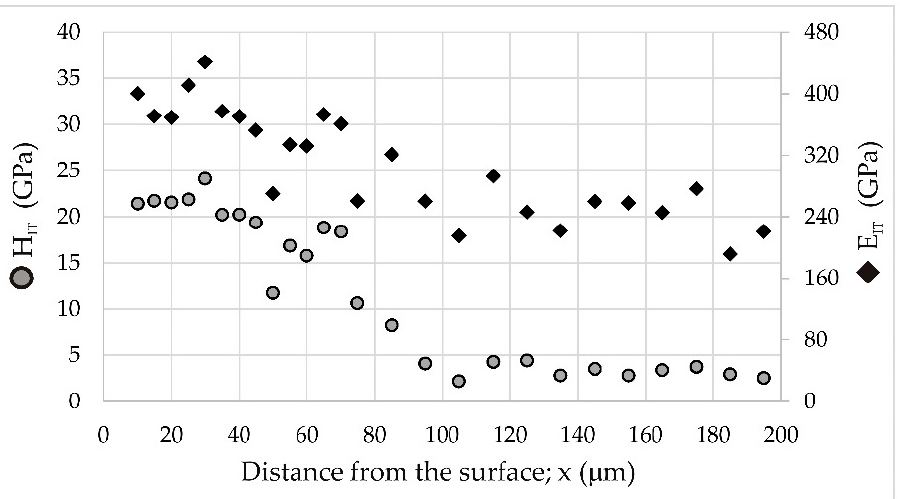
Figure 15. Indentation hardness ( H IT ) and indentation Young’s modulus ( E IT ) profiles of X165CrV12 steel after powder-pack boriding at the temperature of 1223 K for 9 h.